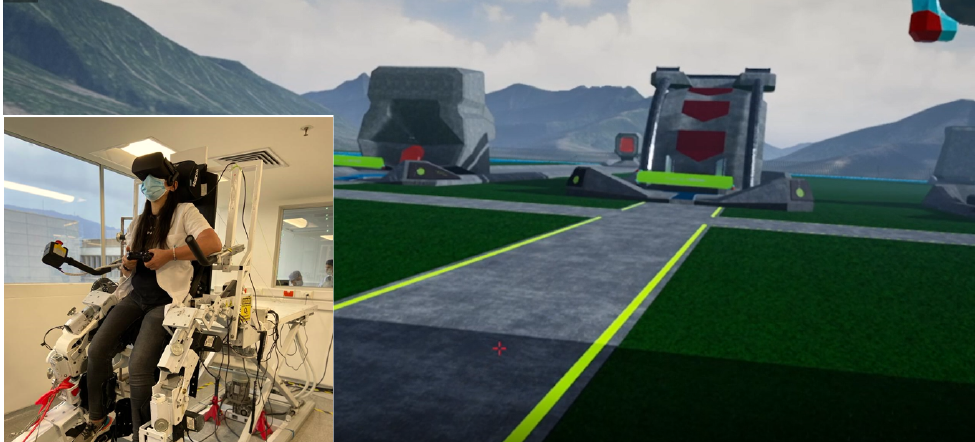
Figure 3. Kina user ( left ) and visualization of the exercise machines in the virtual world ( right